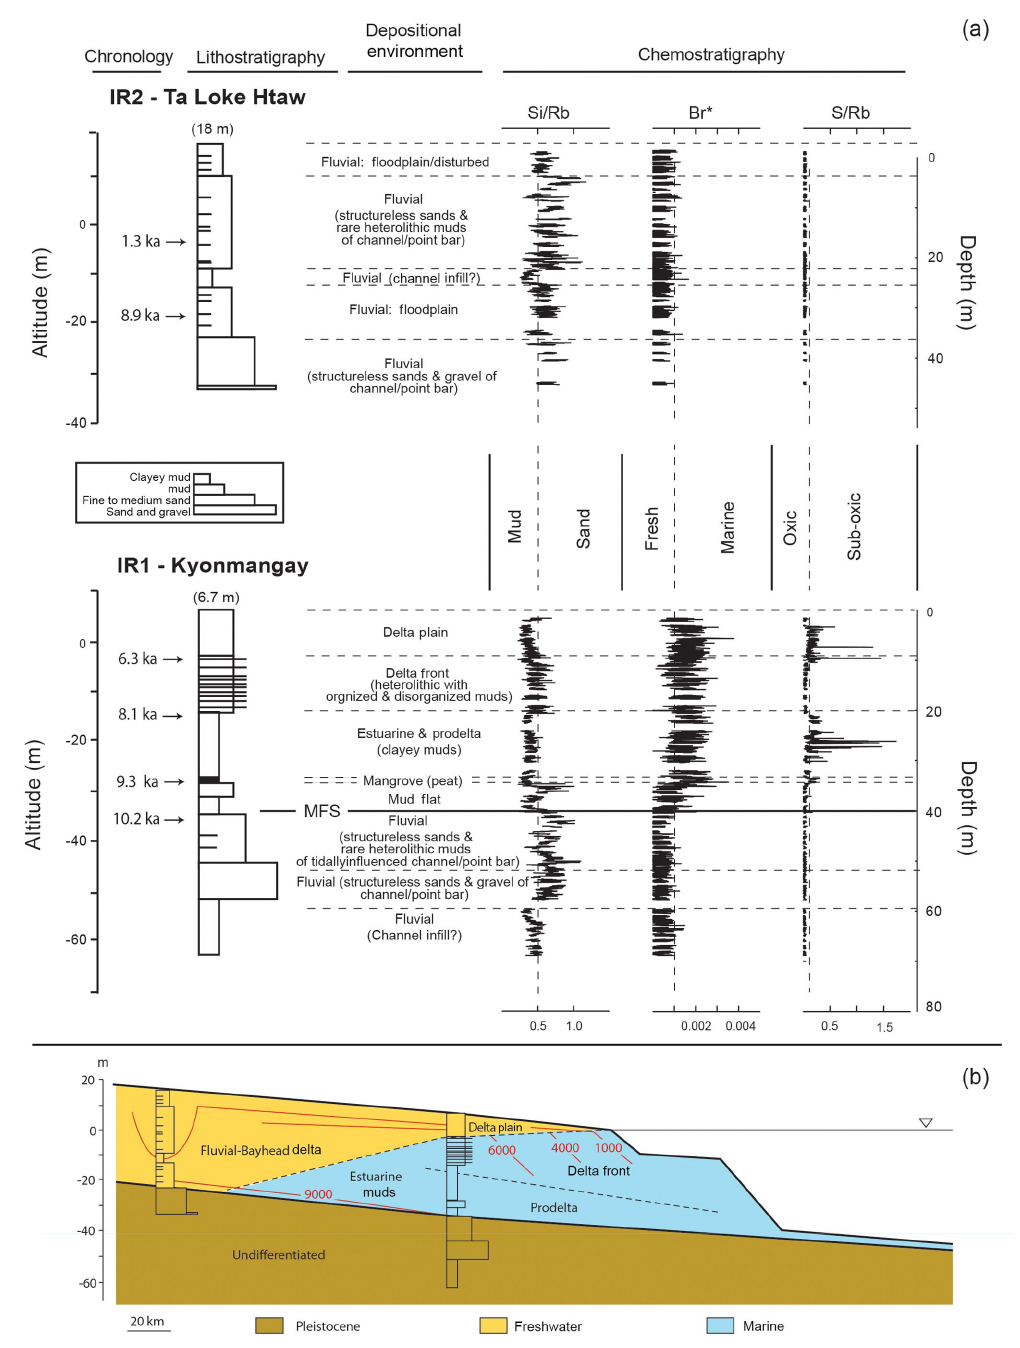
Figure 3. (a) Depositional environments interpreted from litho- and chemo-stratigraphy with radiocarbon chronology for drill cores in the Ayeyawady delta; (b) interpreted Ayeyawady delta stratigraphy and evolution along the Ayeyawady’s main